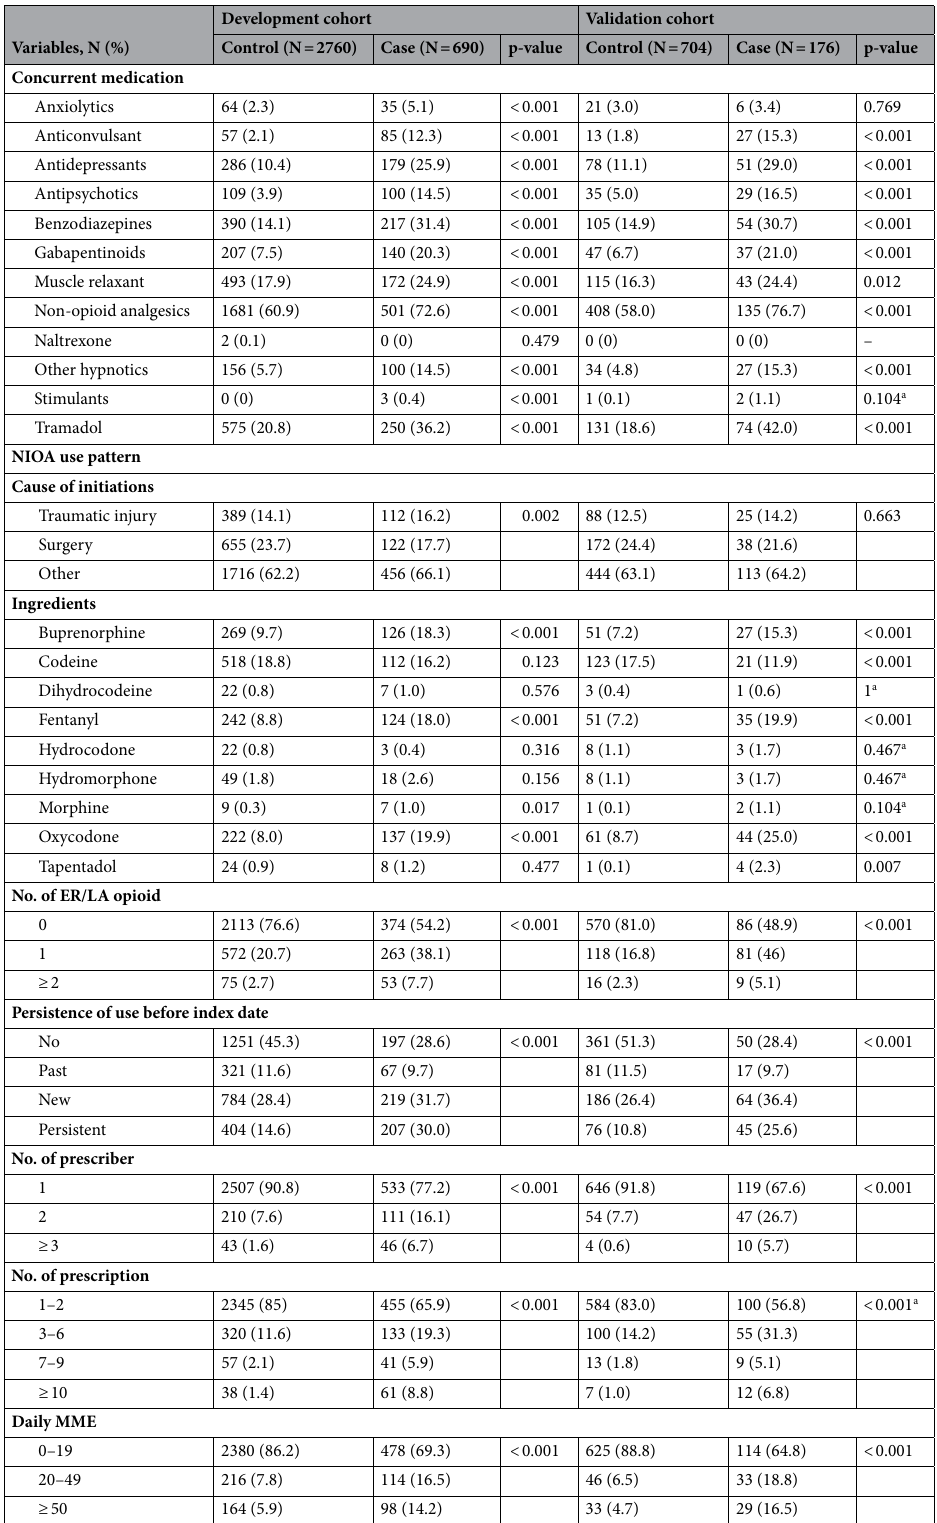
Table 2. Medication use pattern of study participants according to outcomes in the development and validation cohorts. NIOA non-injectable opioid analgesics, ER/LA extended-release and long-acting, MME morphine milligram equivalent. a Fisher’s exact